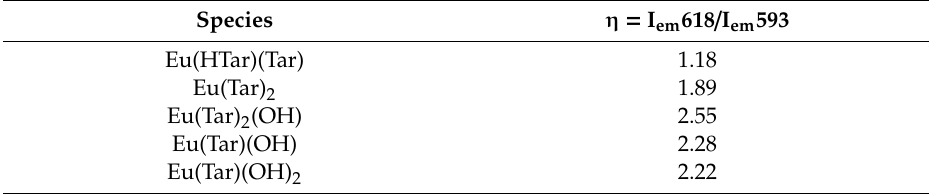
Table 4. The η = I em 618 / I em 593 of binary complexes in Eu(III) / tartaric acid